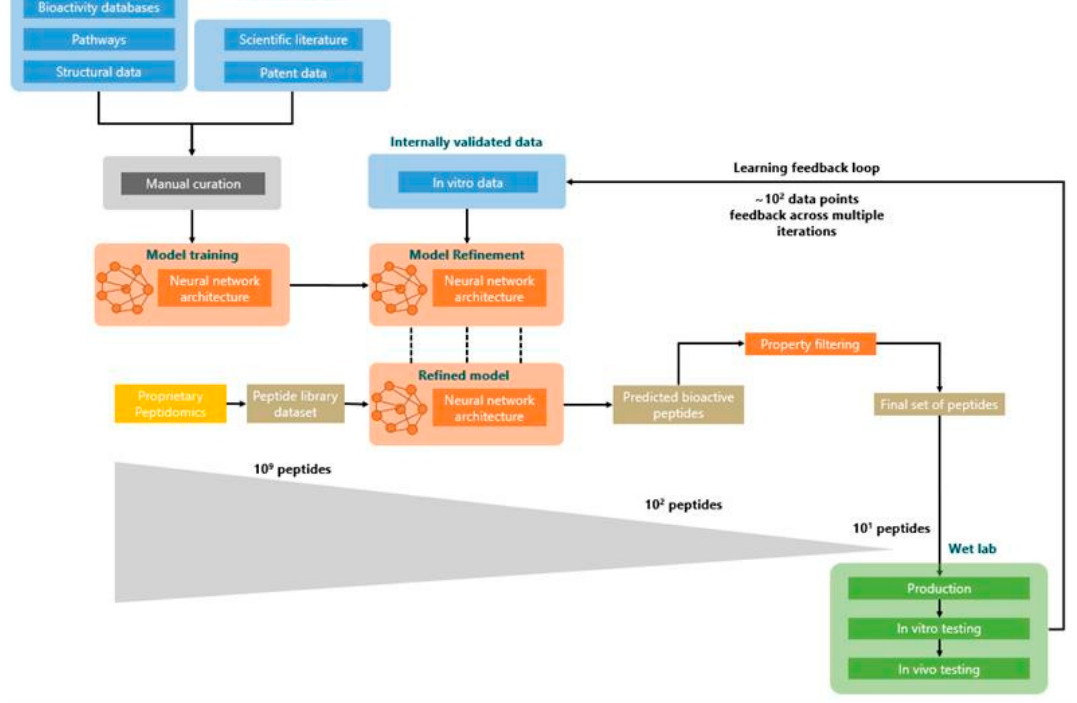
Figure 1. Peptide prediction. Workflow for predictive models adapted from Corrochano et al., 2021 [35].